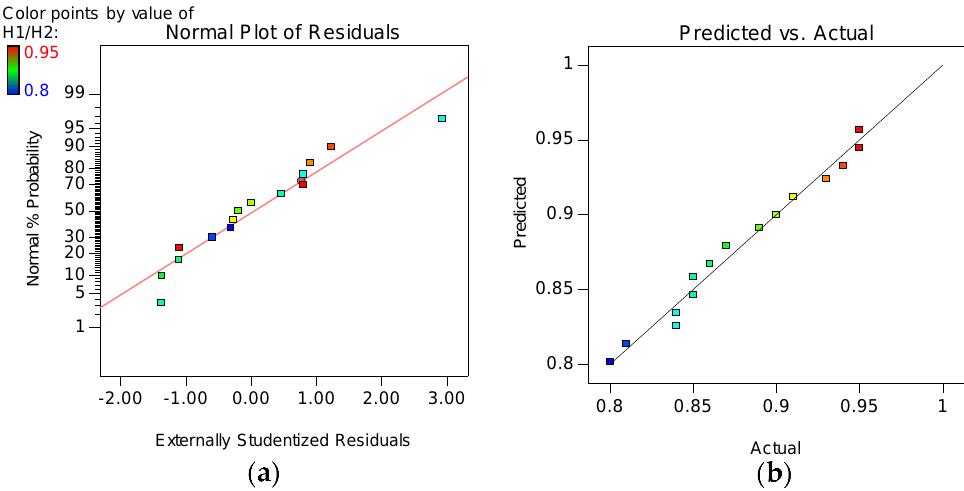
Figure 15. ( a ) Normal plot of residuals and ( b ) Actual vs. Predicted plot for H1/H2.